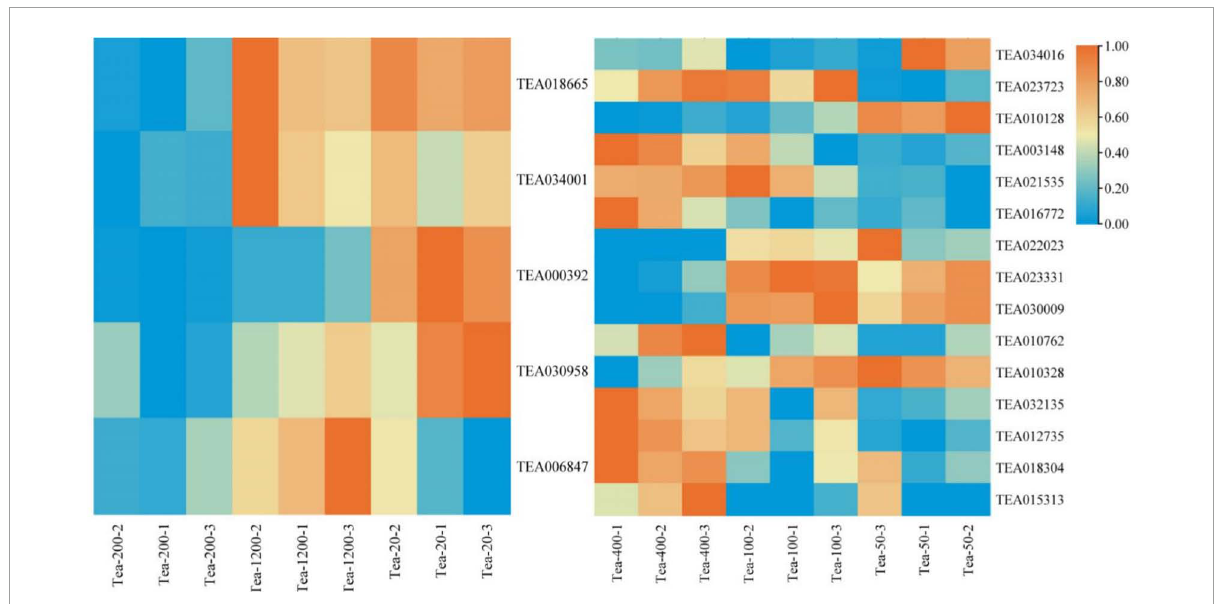
FIGURE5 Heat map of the flavonoid synthesis pathway and related gene expression in tea shoots of different years. The left heat map for Group JP, and the right heat map for Group YX.